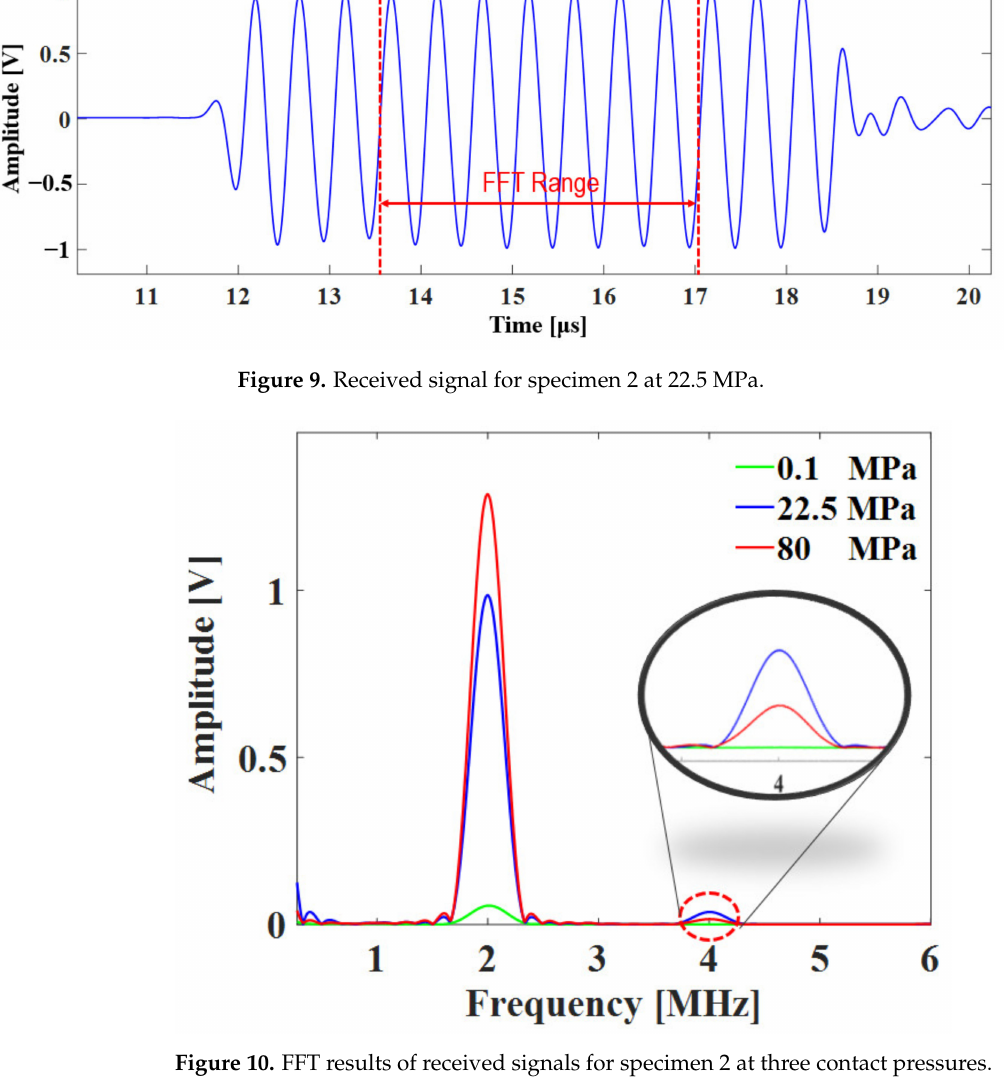
Figure 10. FFT results of received signals for specimen 2 at three contact